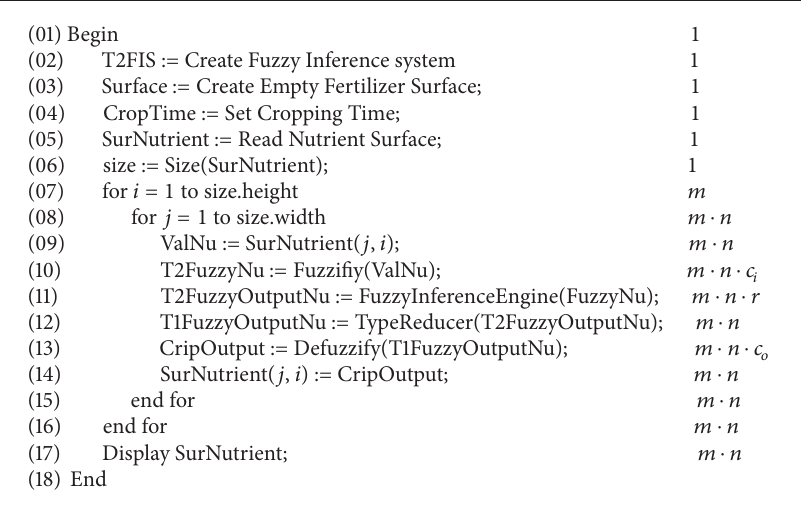
Figure 8: Complexity of